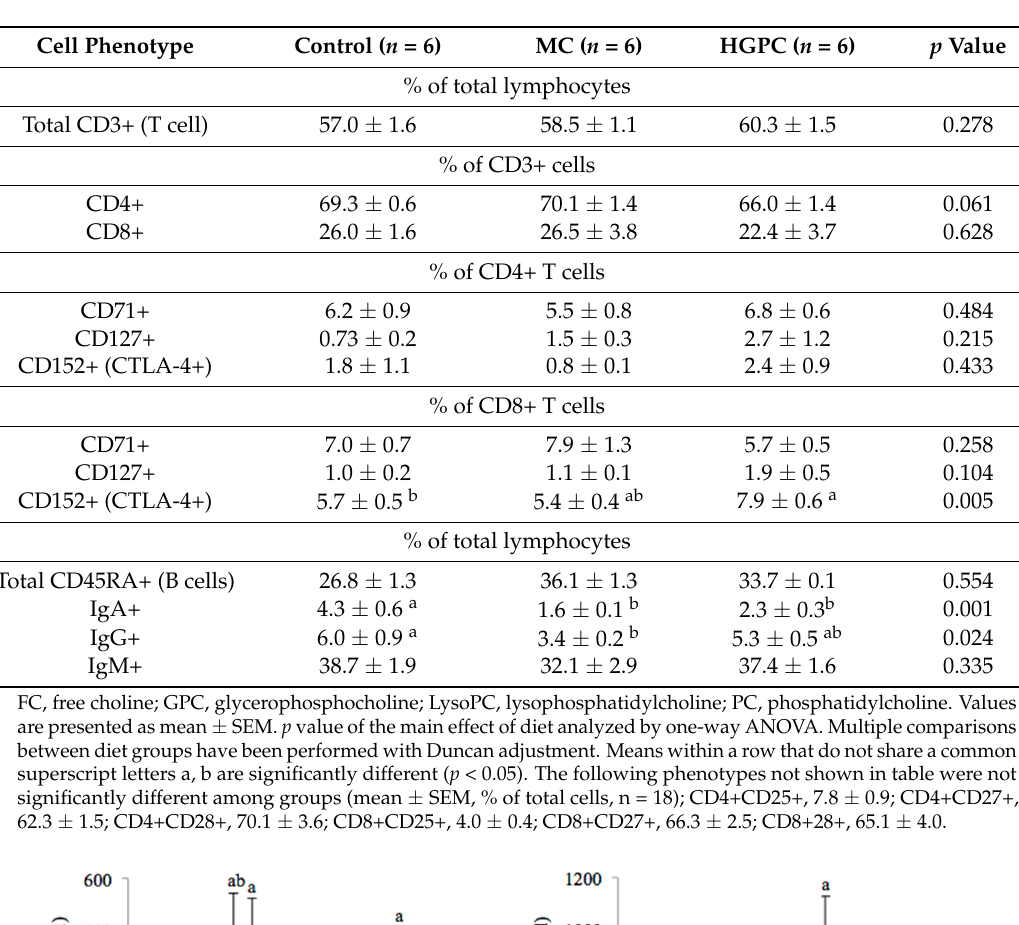
Table 5. Mesenteric lymphocyte phenotypes of lactating dams fed Control (100% FC), Mixed Choline (MC; 50% PC, 25% FC, 25% GPC) or High GPC (HGPC; 75% GPC, 12.5% PC, 12.5% FC) diets.